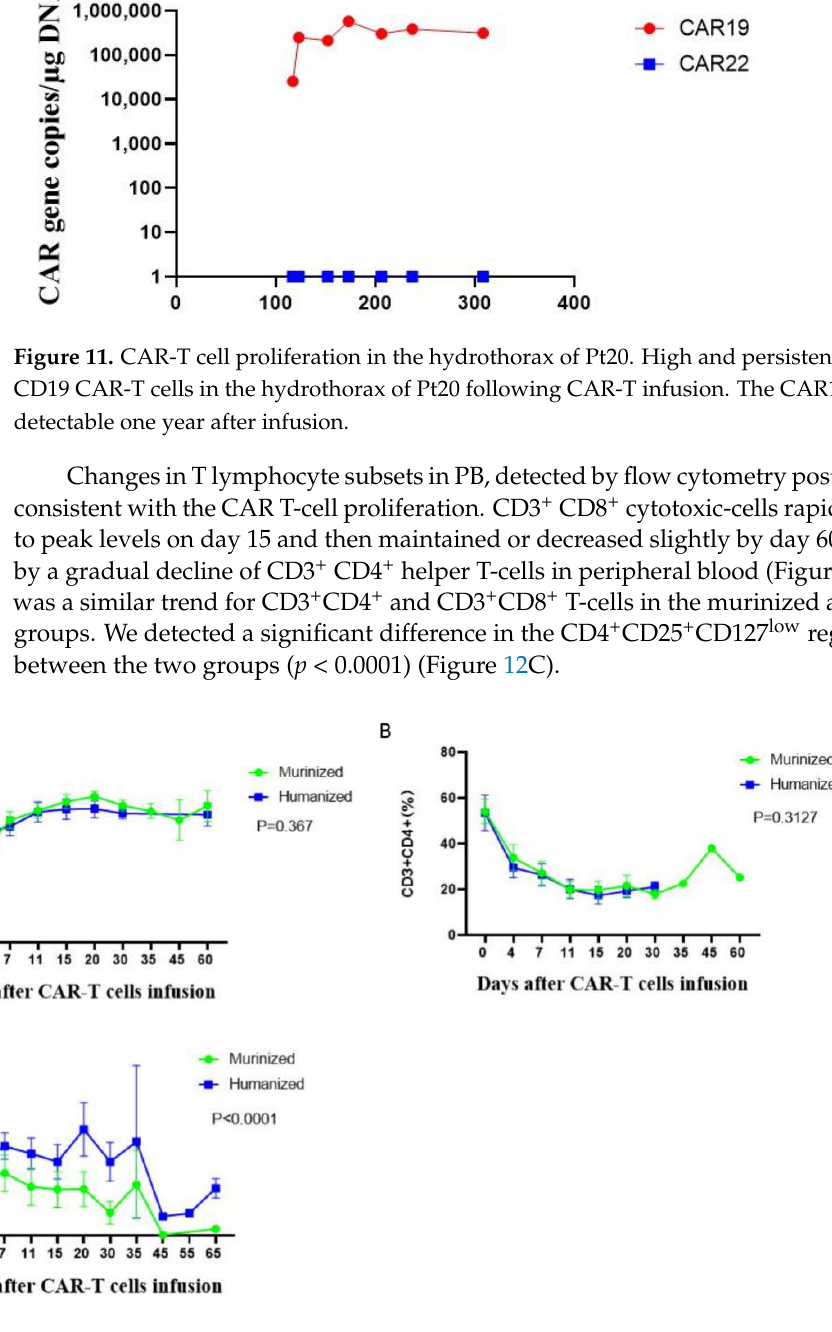
Figure 12. Comparison of T lymphocyte subsets in the murinized and humanized groups. Similar percentage of CD3 + CD8 + ( A ) and CD3 + CD4 + ( B ) in the two groups, while the percentage of CD4 + CD25 + CD127 LOW+ cells ( C ) in the humanized group was much higher than in the murinized group ( p < 0.0001).